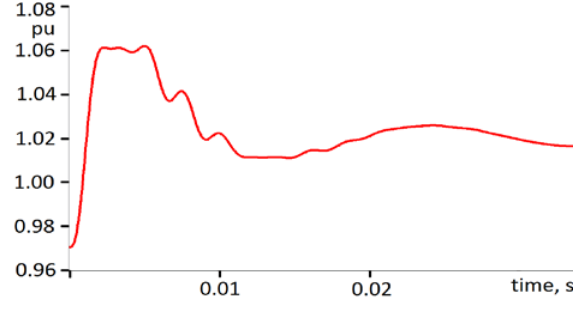
Fig. 7. Course of 1 G M